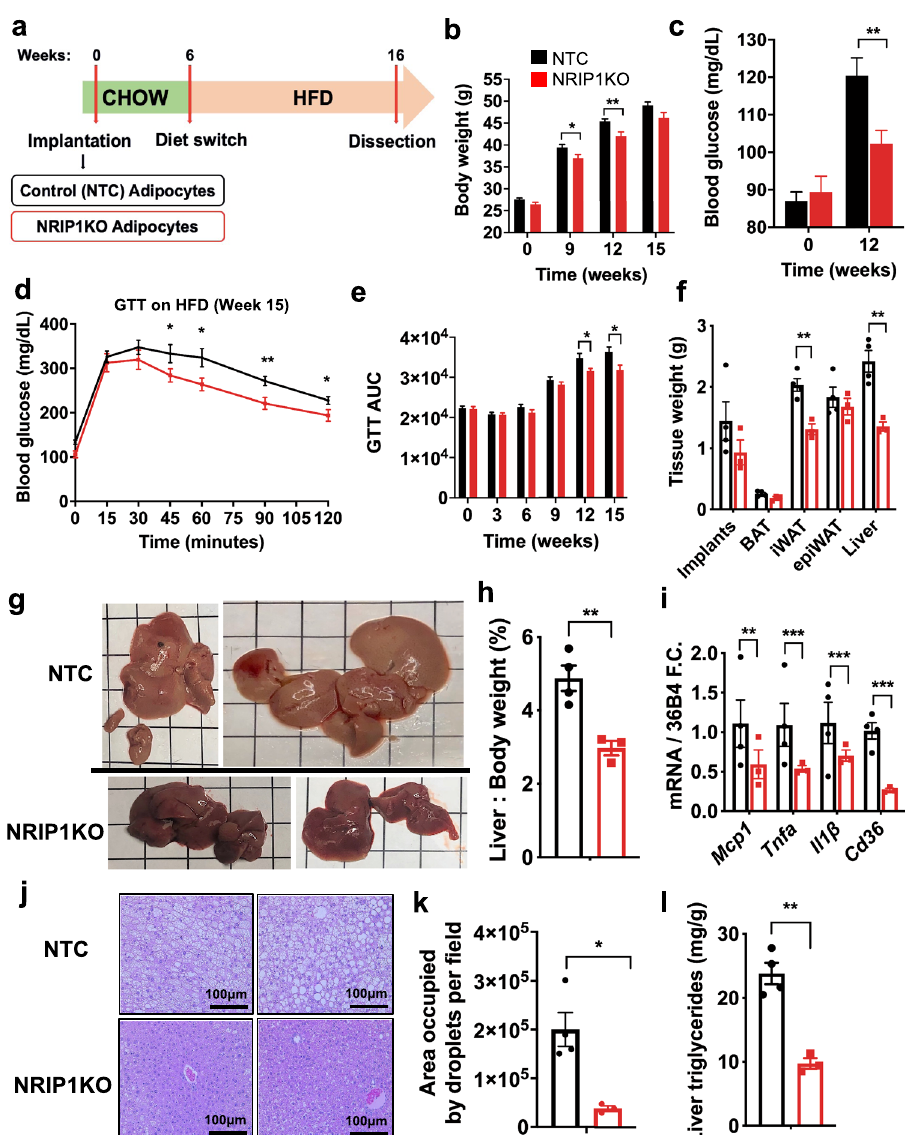
Fig. 3 Implantation of NRIP1-depleted mouse adipocytes improves glucose tolerance and markedly decreases iWAT weight and liver triglyceride accumulation in recipient mice. Mice were implanted with either mouse adipocytes previously transfected with NTC sgRNA/Cas9 RNPs or with sgRNA- M6/Cas9 RNPs (NRIP1KO). a Schematic protocol of implantation of murine NTC adipocytes or NRIP1KO adipocytes into C57BL/6 wild type mice followed by 60% kCal fat diet (HFD). b Total body weights of recipients on chow before implantation and 6, 9, 12, 15 weeks after implantation on HFD. P values *9 weeks = 0.034; **12 weeks = 0.008; 15 weeks = 0.058 c Fasting blood glucose concentrations at baseline ( p = 0.626) and 12 weeks ( p = 0.005) post implantation (6 weeks on HFD). d Glucose tolerance test (GTT) after 16-hour overnight fasting in implant recipients after 9 weeks on HFD. P